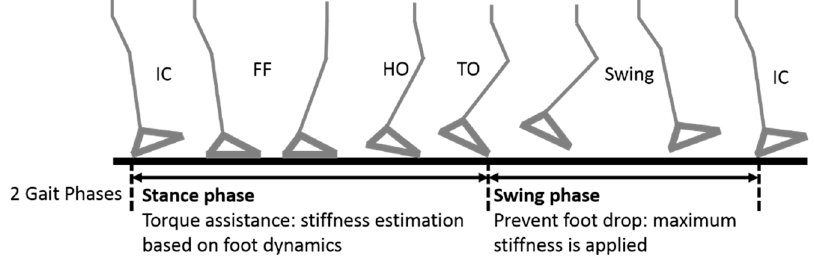
Figure 4. Reported gait phase classifications, namely, 2, 3, and 4-phased gaits.